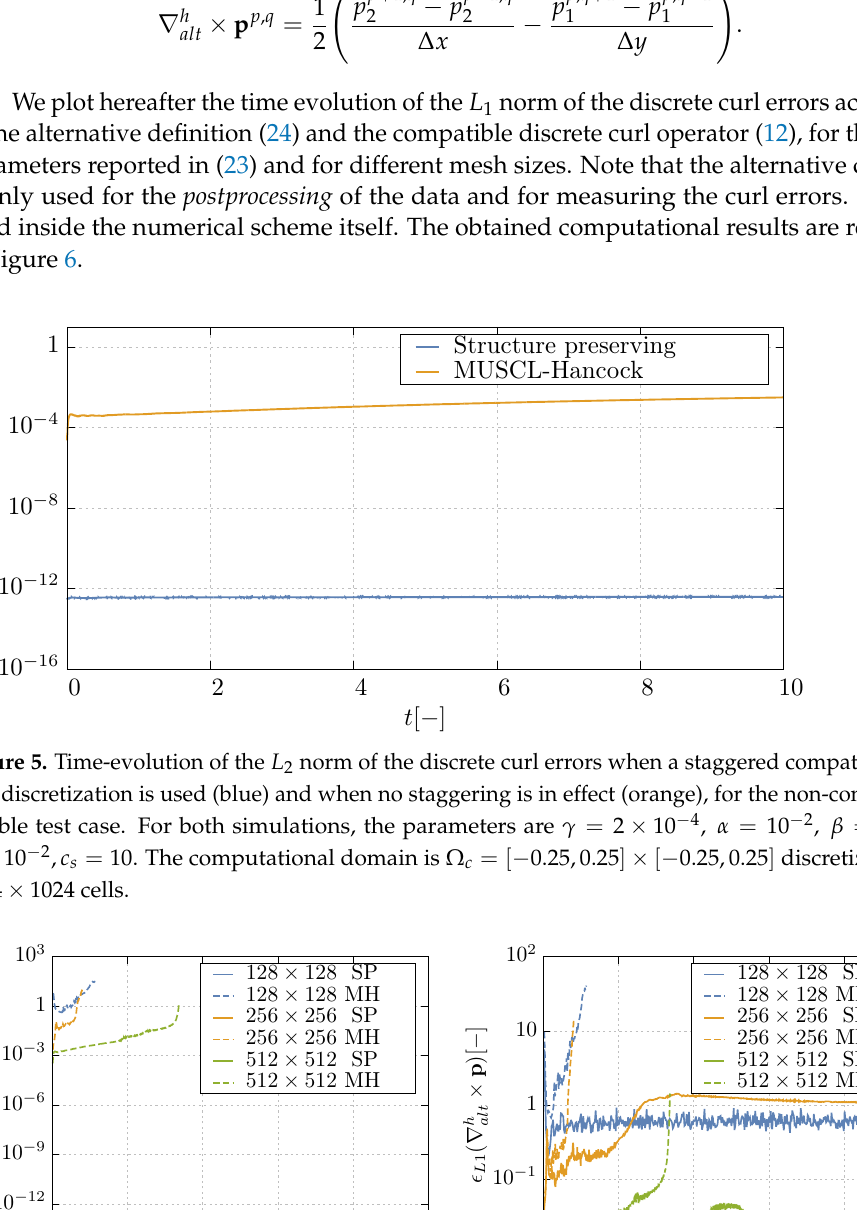
h (left) and h alt ∇ ∇